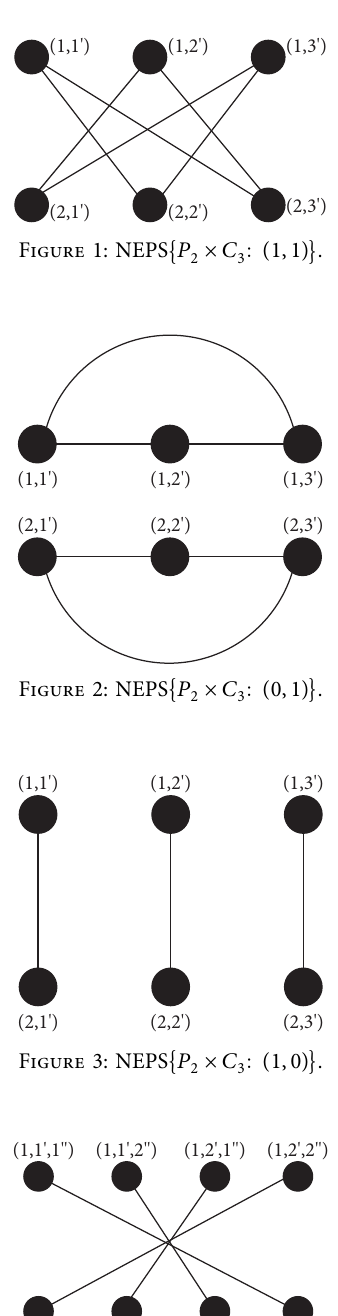
× P × P : ( 1 , 1 , 1 ) 􏼈 􏼉 . 2 2 2